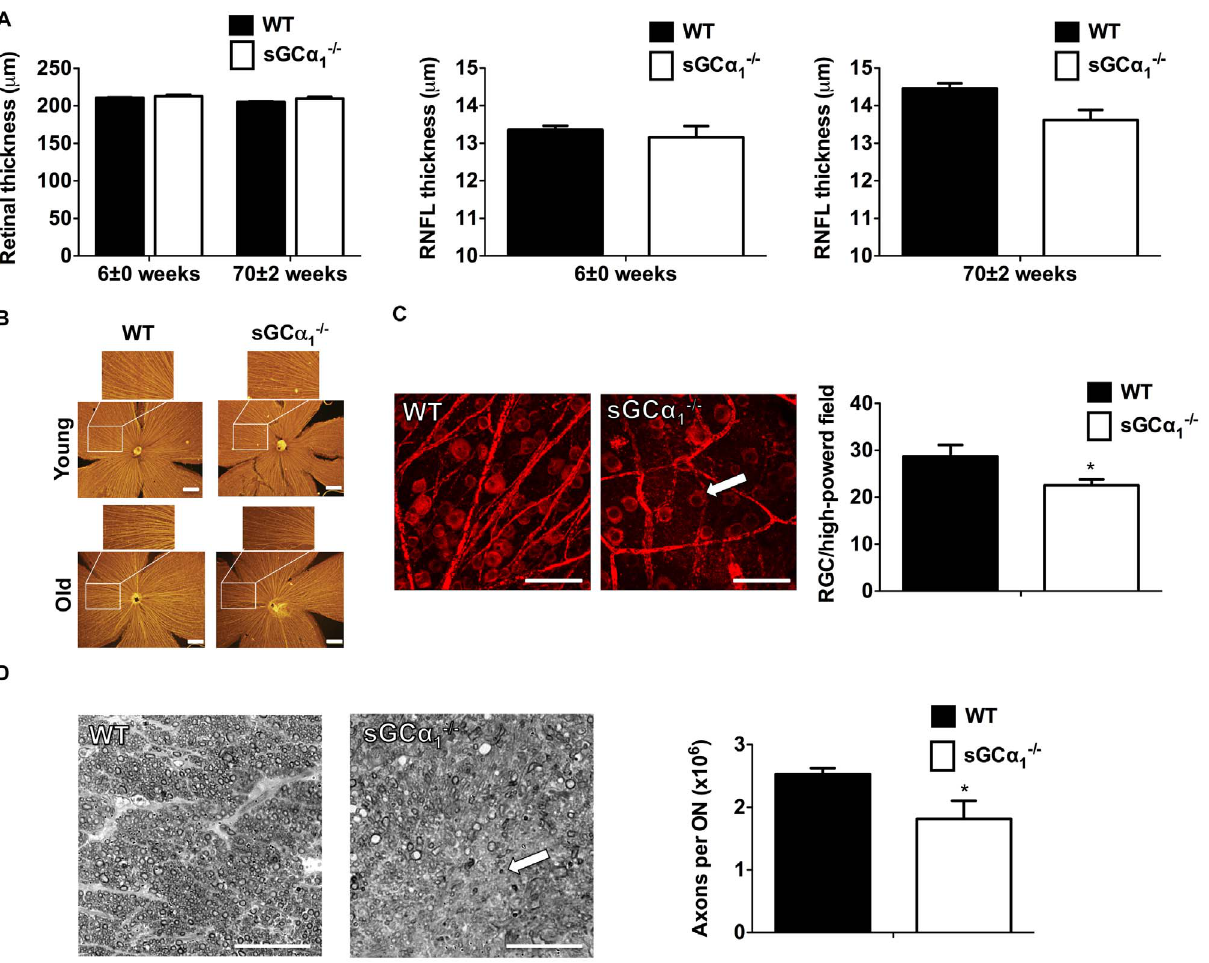
Figure 2. Retinal nerve fiber layer (RNFL) thinning and glaucomatous optic neuropathy in sGC a 1 2 / 2 mice. A : Quantitative analysis, assessed by SD-OCT (see also fig. S1), of total retinal thickness ( left panel ) and RNFL thickness, in young (6-week-old, middle panel ) and old (70- week-old, right panel ) wild-type (WT, n =19 and 13, respectively) and soluble guanylate cyclase a 1 -deficient (sGC a 1 2 / 2 ) mice ( n =15 and 14, respectively; * P =1.2 6 10 2 2 ). B : Representative whole-mount retinas from age-matched young (20-week-old) and old (56-week-old) WT and sGC a 1 2 / 2 mice, reacted with antibodies directed against SMI32, staining retinal nerve fibers yellow. Scale bars: 500 m m. C : Representative confocal images, taken at a similar distance from the optic nerve, of flat-mounted retinas isolated from age-matched 52-week-old WT and sGC a 1 2 / 2 mice that were reacted with antibodies directed against b III Tubulin, and quantitative analysis of the number of RGCs/high-powered field ( n =8 and 7, respectively; * P =3.6 6 10 2 2 ). A retinal ganglion cell (red) is indicated by an arrow. Scale bars: 20 m m. D : Representative cross sections through the optic nerve of 52-week-old WT and sGC a 1 2 / 2 mice stained with paraphenylenediamine, and quantitative analysis of the calculated number of axons/optic nerve (ON). The arrow indicates an injured area in the optic nerve, characterized by the absence of well-formed myelinated axons ( n =7 and 6, respectively; * P =4.9 6 10 2 2 ). Scale bars: 25 m m.